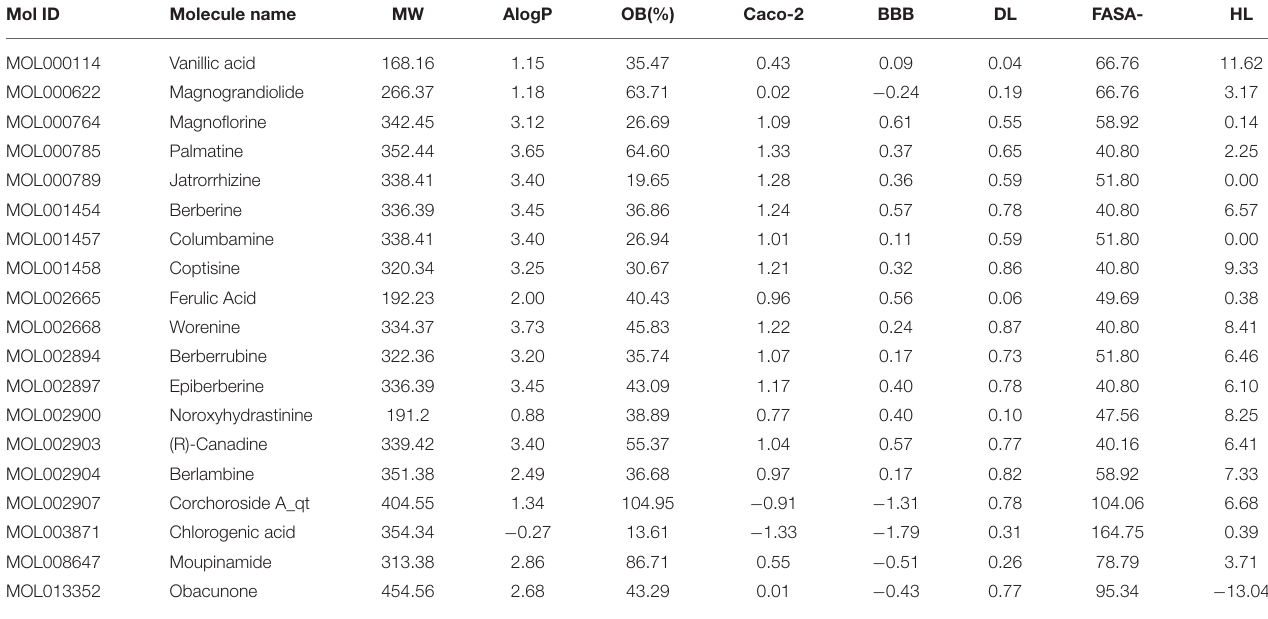
TABLE 1 | Physicochemical information of 19 potentially active